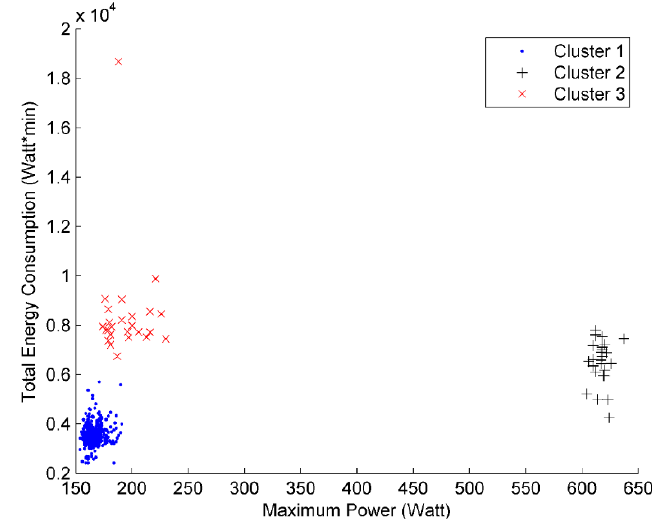
Figure 7. Clustering results for cycles start between 1:00 a.m. to 6:59